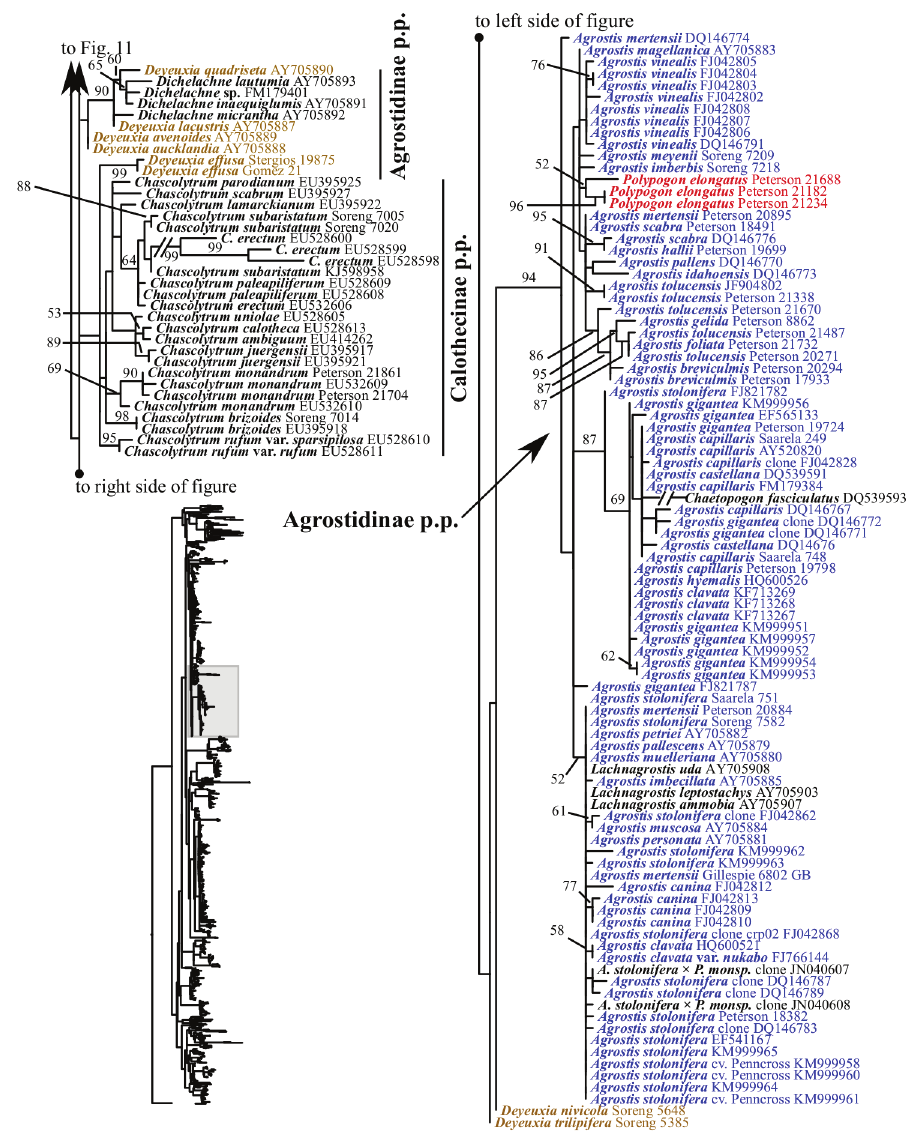
Figure 12. A portion (part of Agrostidinae p.p. and Calothecinae p.p.) of the maximum likelihood phylogram inferred from ITS data. ML bootstrap support is recorded along branches when >50%. The shaded area of the smaller tree on the left indicates the location in the overall tree of the portion shown. resolution. Another clade includes the other three species of Koeleria (83, 1; Fig. 20). Relationships among these two lineages and Gaudinia are